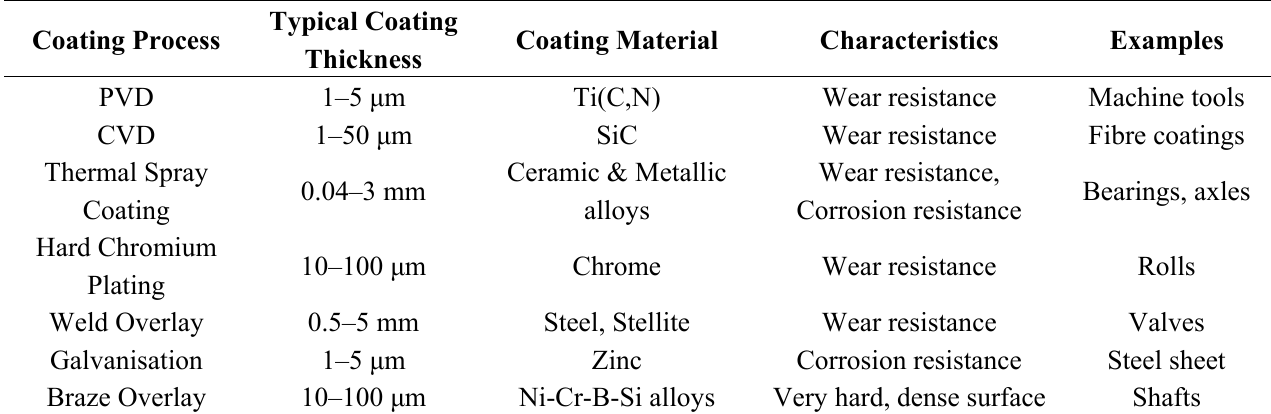
Table 1. Principal coating processes and their characteristics